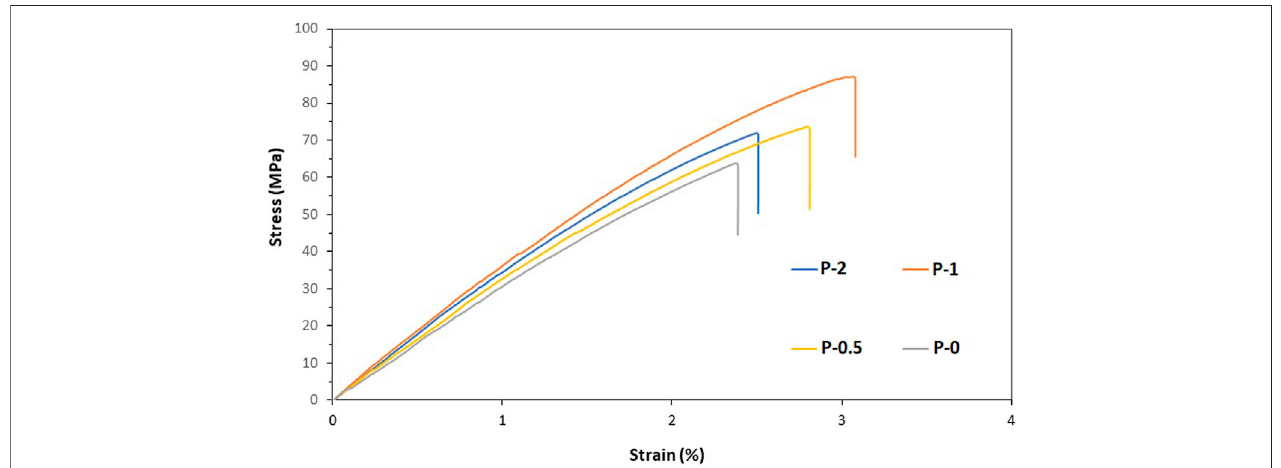
FIGURE 6 | Stress-strain curve for 3D printed PEEK samples containing 0, 0.5, 1, and 2wt% IF-WS 2 .